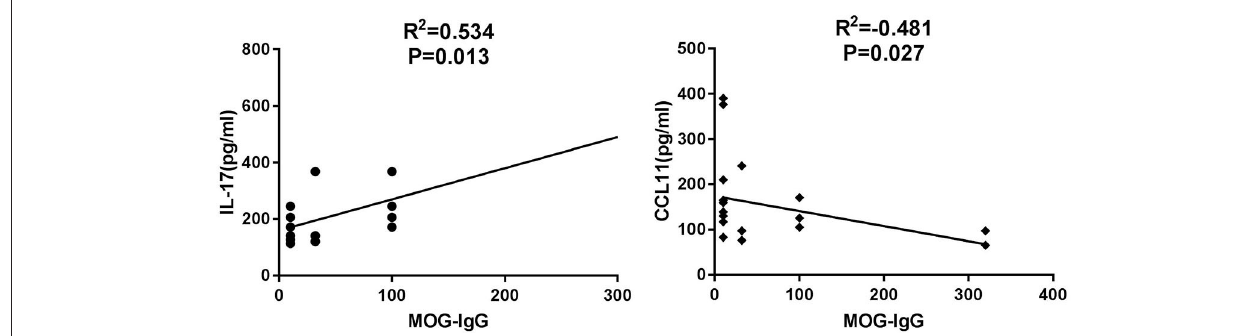
FIGURE 2 | Relationship between Th17-related serum cytokines/chemokines and serum MOG-IgG titer in MOG-IgG-seropositive ON patients.